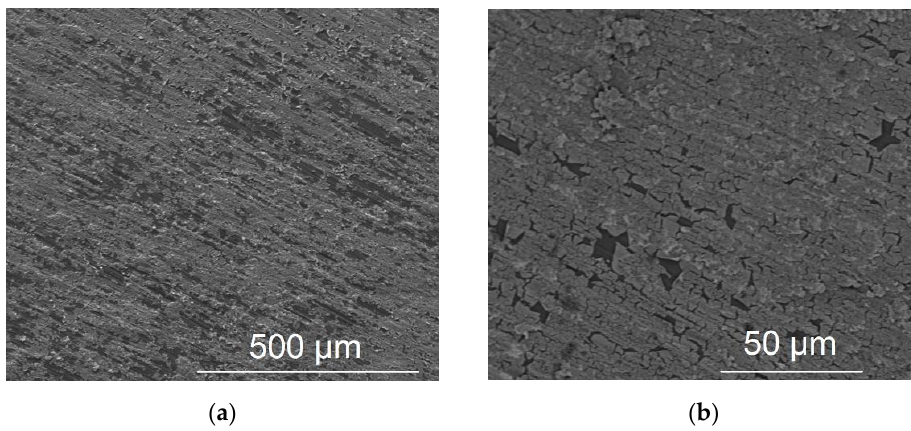
Figure 3. SEM micrographs of Pt/Ti foil: ( a ) SEI at a magnification of ×150 and ( b ) BEI at a magnification of ×1k.